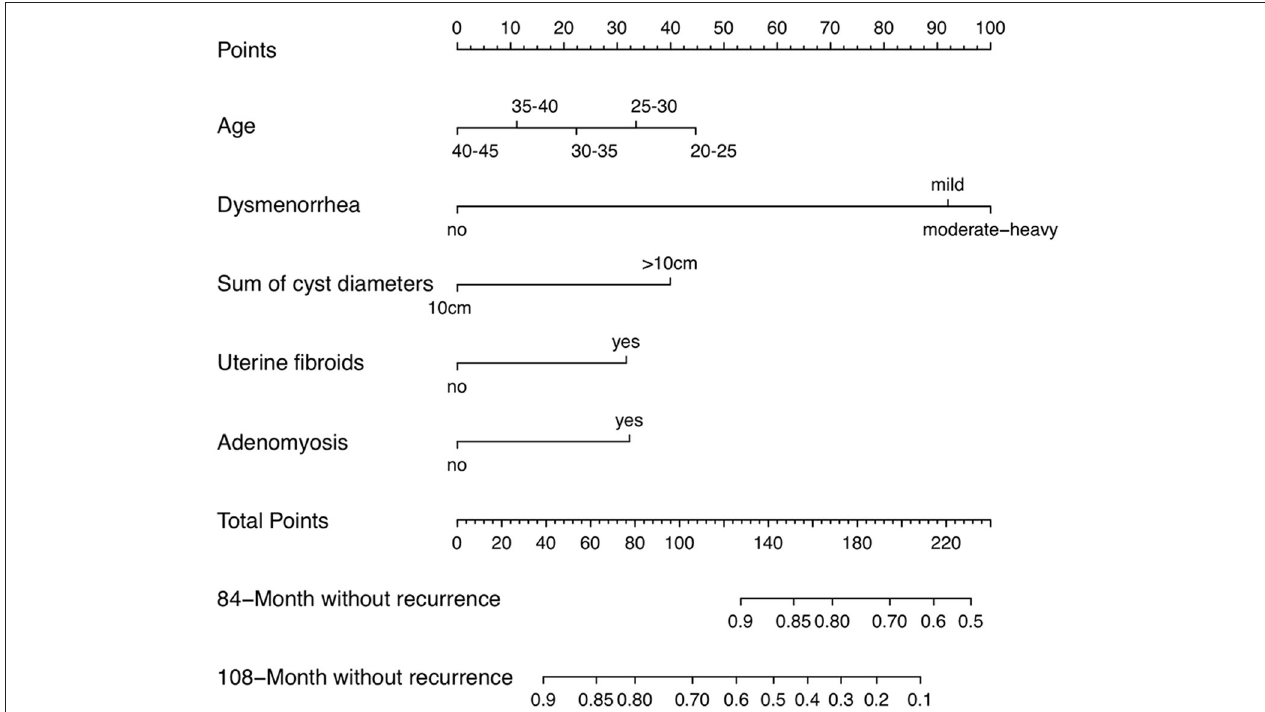
FIGURE 1 | Endometrioma recurrence nomogram (To use a nomogram, you need to locate individual patient values on each variable axis, and then draw a line up to determine the number of points received for each variable value. The sum of these numbers is on the “total points” axis, and a line is drawn down on the survival axis to determine the probability of without recurrence of 84-month or